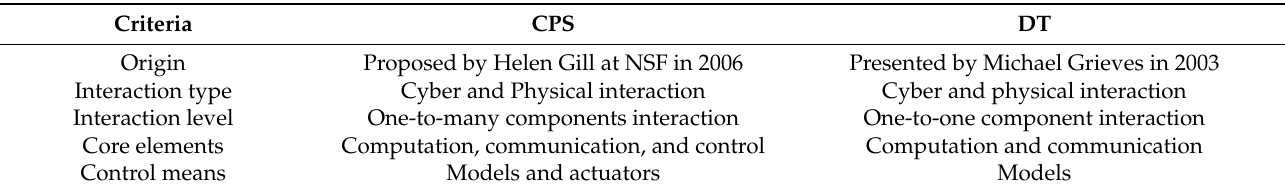
Table 2. General differences of CPS and DT